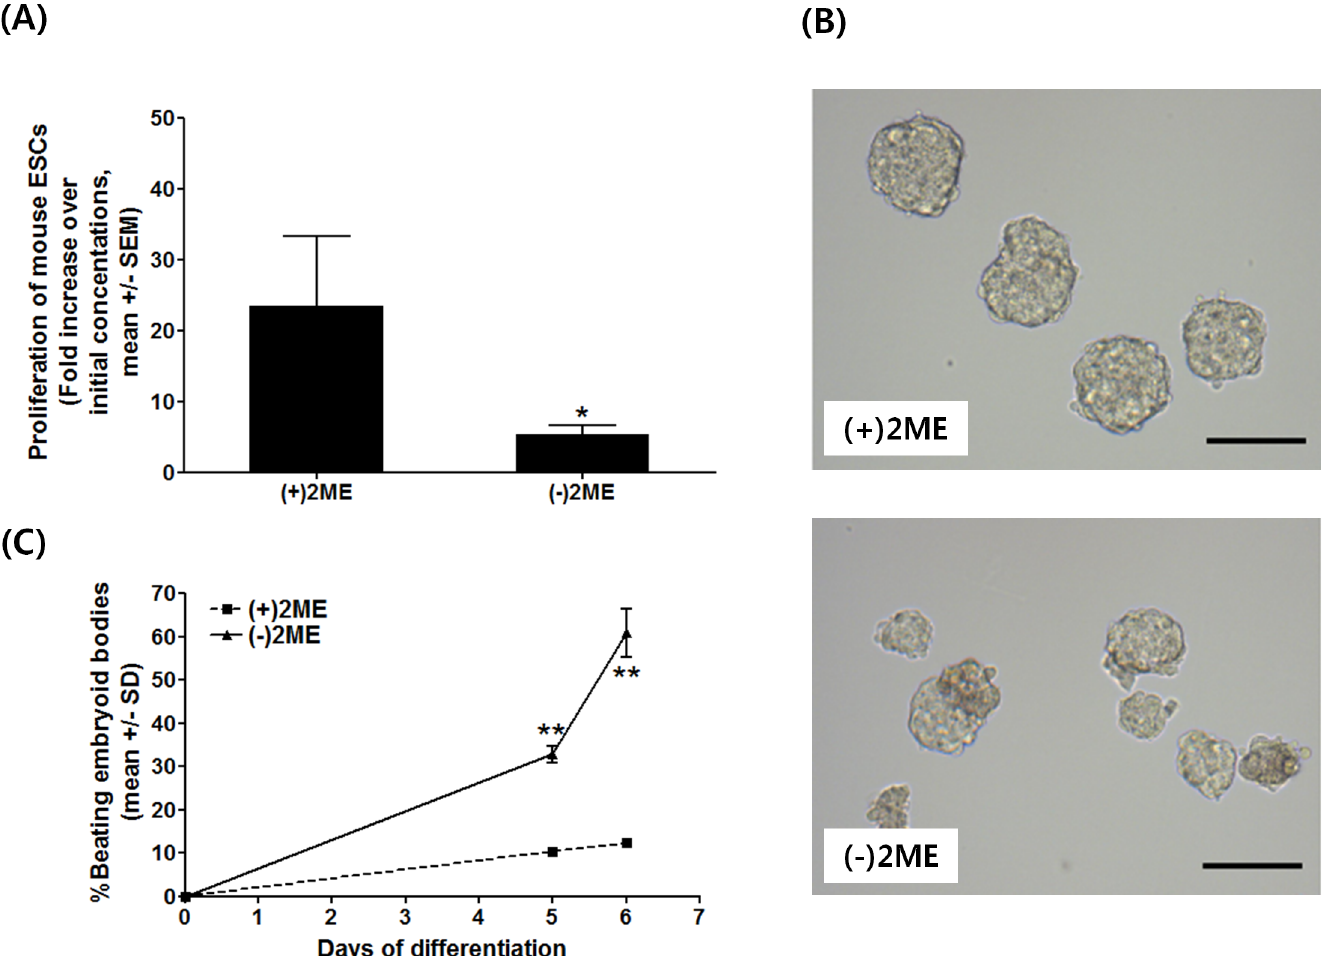
Fig 2. Effects of oxidative stress on R1 mouse ESC proliferation and differentiation. (A) Proliferation of ESCs after oxidative stress induced for two days by removing 2-mercaptoethanol (2ME) from ESC medium. * p < 0.05, Welch t-test. Means of fold changes with standard errors were presented. (B) Different EB morphologies from (+)2ME and (-)2ME media (bar = 100 μ m) and (C) the percentages of beating EBs were observed from oxidative-stressed ESCs vs. controls ( ** p < 0.01, one-sided